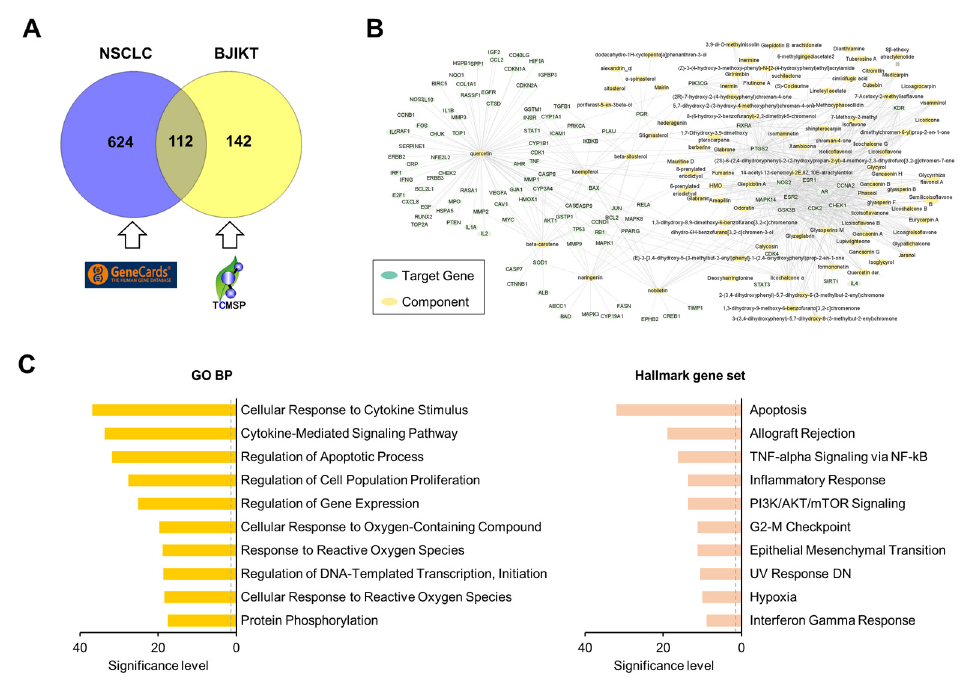
Figure 5. Network pharmacological analysis of BJIKT on NSCLC. ( A ) Venn diagram for 736 NSCLC- related genes obtained from GeneCard and 254 target genes of BJIKT obtained from TCMSP; 112 genes were common. ( B ) Reconstructed network for molecular targets of BJIKT components acting on NSCLC. ( C ) Top 10 enriched pathways for the common 112 target genes using GO BP (left) and the Hallmark gene set (right). The significance level of each pathway term was calculated as − log10 (adjusted p -value). The dashed gray line denotes a p -value of